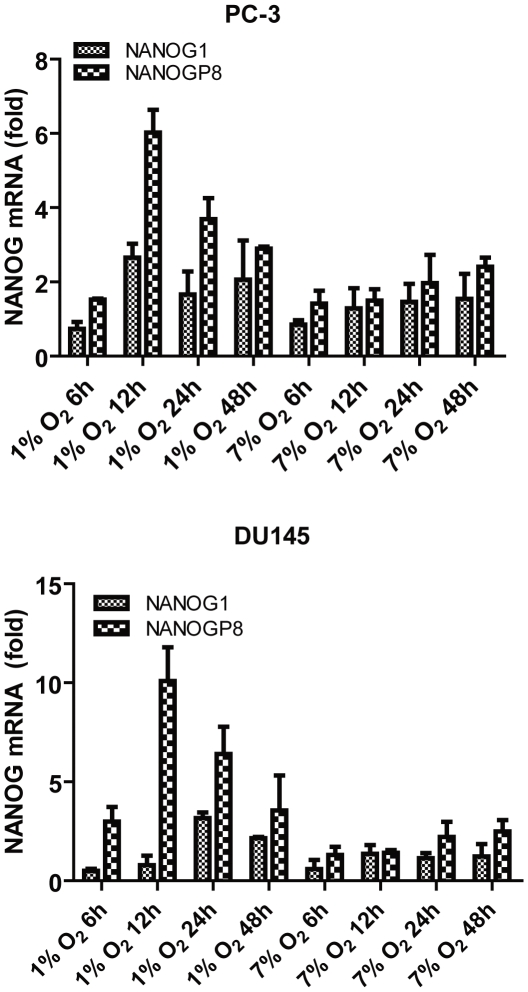
Quantitative PCR results of NANOG1 and NONOGP8.Compared to the cells under normoxia, there are elevated NANOG1 and NONOGP8 expressions in the cells under 7% O2 for both cell lines, with up to 1.8-fold increase NANOG1 expression and up to 2.5-fold NONOGP8 increase in both cell lines; the cells under 1% O2 express even higher levels of NANOG1 and NONOGP8, with 2.6-fold and 3.1-fold increase in NANOG1 expression in the PC-3 and DU145 cell lines, respectively, and with 6-fold and 10-fold increase in NONOGP8 expressions in the PC-3 and DU145 cell lines, respectively.